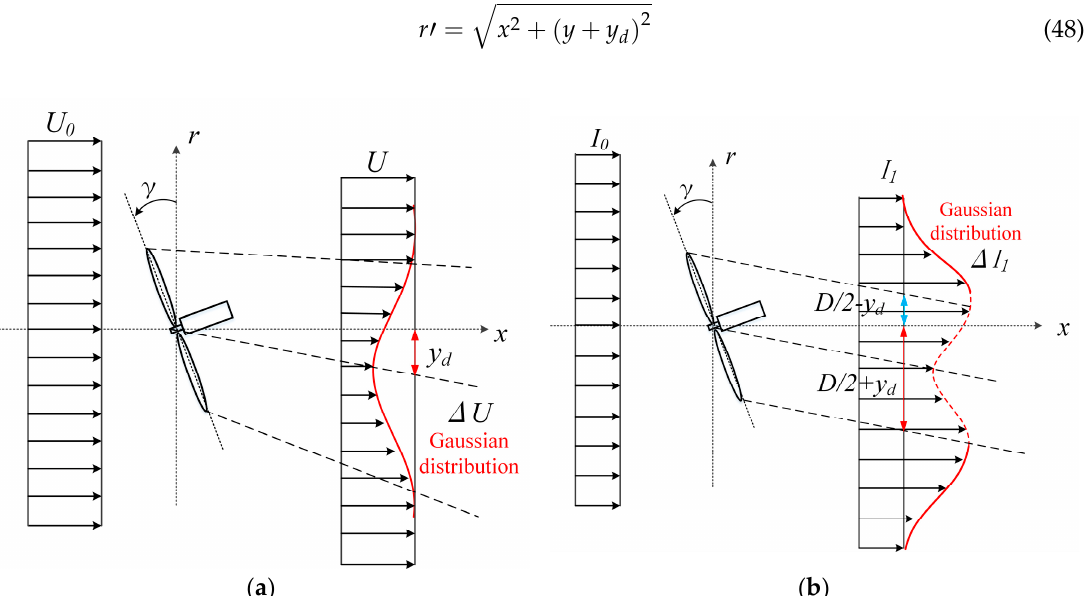
Figure 10. Schematic of the Gaussian-based wake model in yawed condition: ( a ) mean velocity ( b ) turbulence intensity.